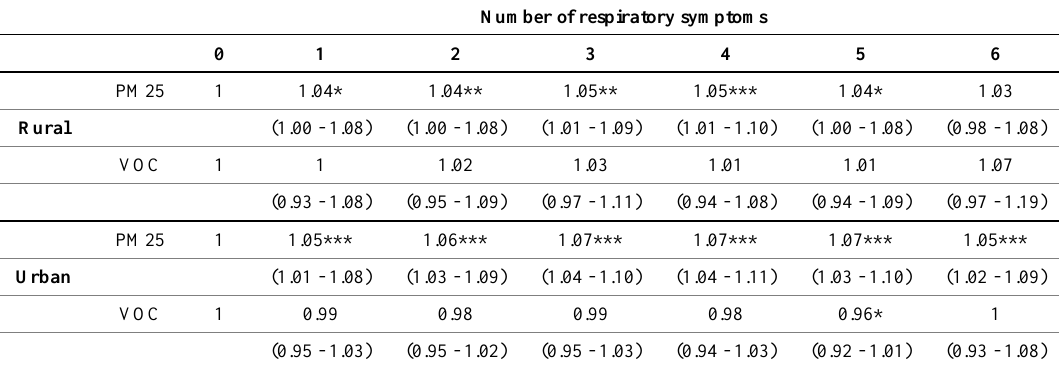
Table 7. Showing the association between maternal respiratory symptoms (MRS) and household air pollution (PM2.5 and